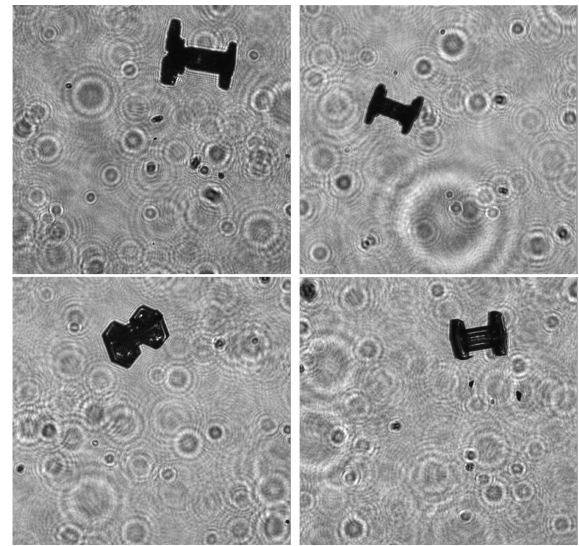
Figure 1. Imaging nephelometer views of capped columns from Airbus flight tests. Images are 512 × 512 square pixels 3µm in width, for a total image size of about 1 . 5mm × 1 . 5mm. Maximum dimen- sions of these capped columns are about